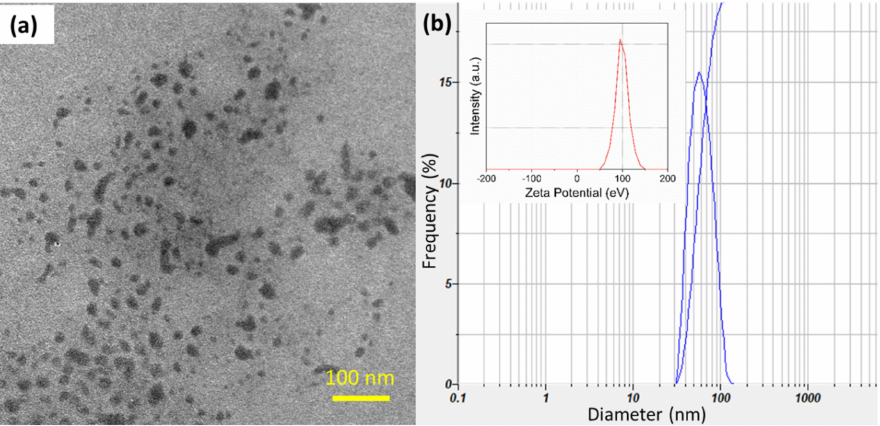
Figure 1. ( a ) TEM image and ( b ) the size distribution of prepared SCNs (Inset is the zeta potential of SCNs). The mean size is approximately 56